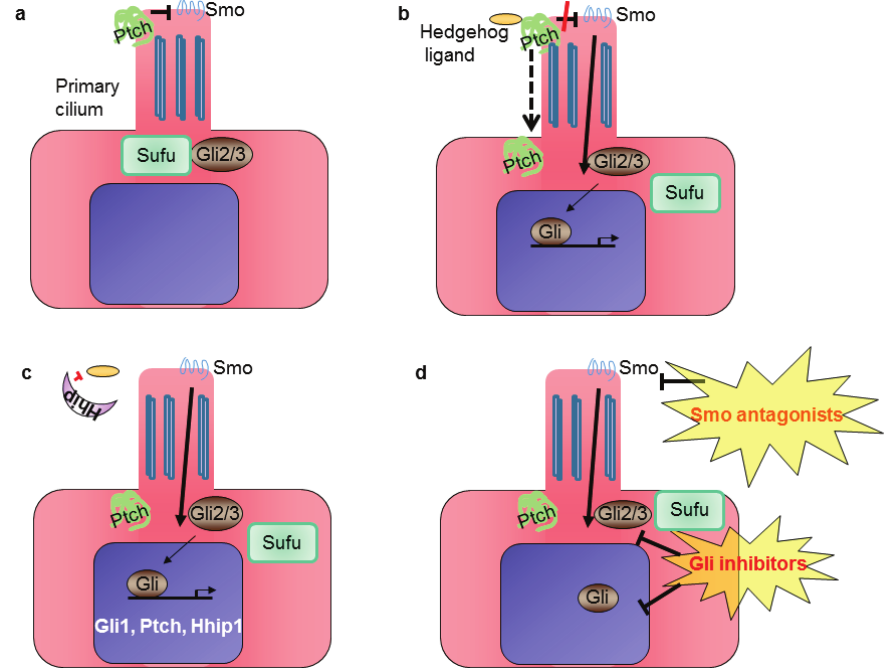
Figure 2. Simplified scheme of Hh signaling in mammalian cells: ( a ) in the absence of Hedgehog ligand, patched 1 (Ptch) localizes to the primary cilium, where it prevents activation of smoothened (Smo); ( b ) Hh signaling is activated upon binding of the ligand to the Ptch receptor, which leaves the cilium, releases the inhibition of Smo and leads to glioma-associated (Gli) transcription factors ’ translocation into the nucleus; ( c ) Gli activates the expression of target genes Gli1 , Ptch and Hedgehog interacting protein ( Hhip1 ); ( d ) the pathway can be inhibited at the level of Smo or